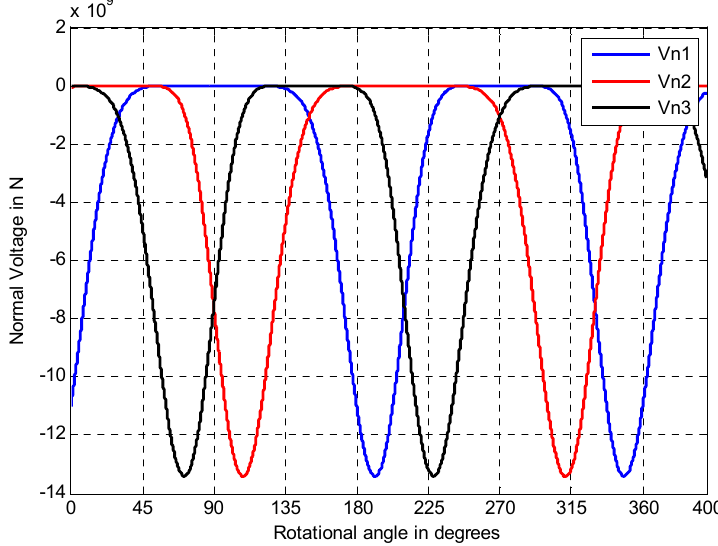
Figure 16. Normal voltage variations of the blade as a function of the rotational angle.